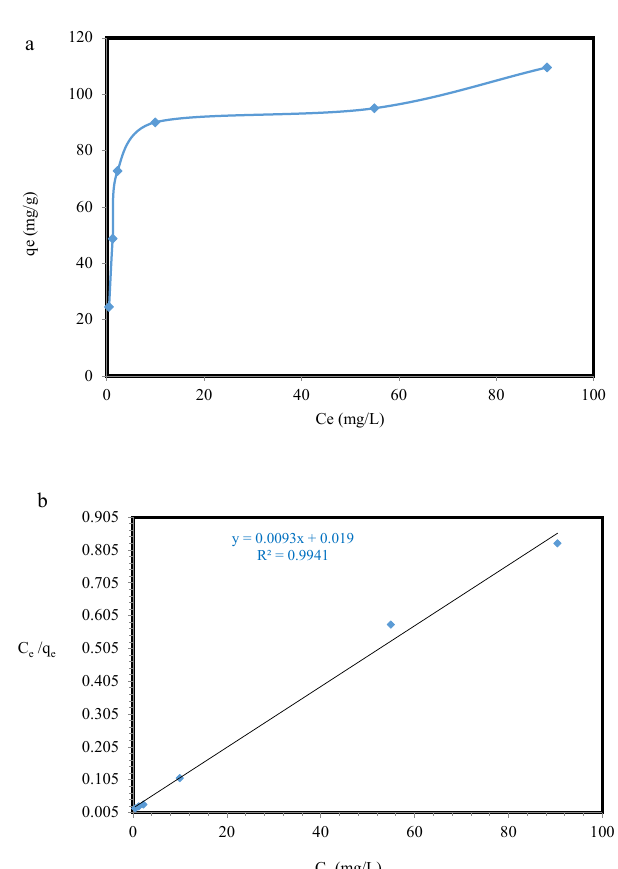
Fig. 11 (a) Effects of initial concentration for the removal of Pb (II) onto Fe 3 O 4 /RGO nanocomposite, (b) Langmuir isotherm plot, (c) Freundlich isotherm plot, and (d) Dubinin-Radushkevich isotherm